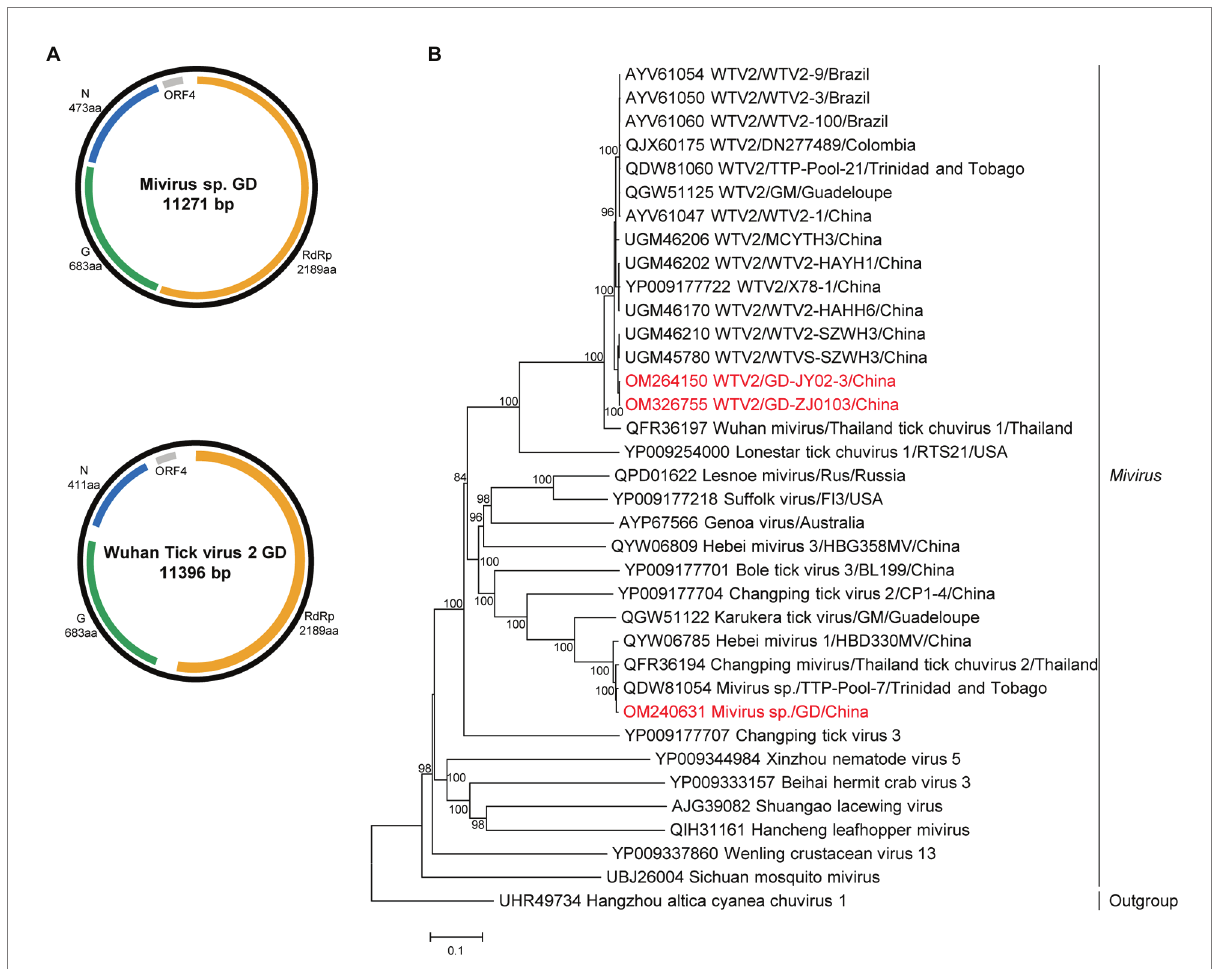
FIGURE 2 The genome structure and phylogenetic analysis of miviruses. (A) Genome organization and putative coding regions of Mivirus sp. (MIV) and Wuhan tick virus 2 (WTV2). The viral genome contains one segments that encoding the RdRp, glycoprotein (G), nucleoprotein (N) and ORF4. (B) Phylogenetic analyses of miviruses. Phylogenetic trees were constructed based on the RdRp protein sequences of representative viruses in the genus Mivirus . Viruses obtained in ticks here are highlighted in red. Scale bar indicates nucleotide substitutions per